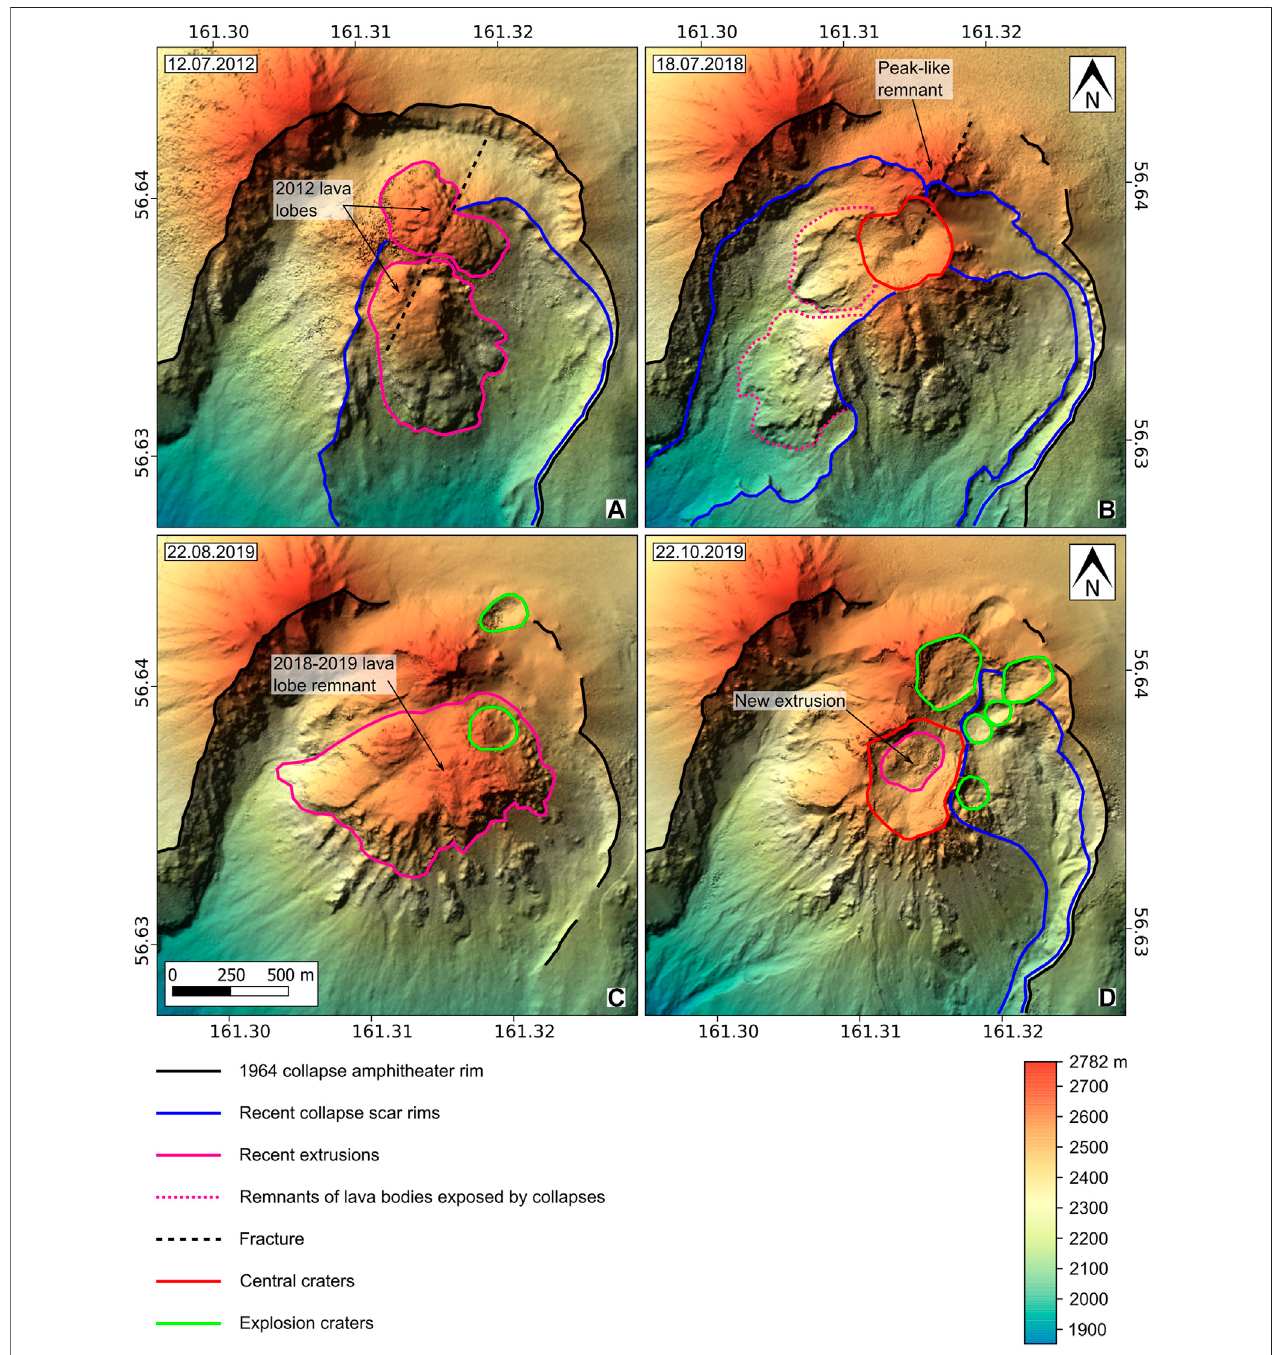
FIGURE3| Hillshade maps oftheYoungShiveluch domefor the2012basemap and three acquisitionscovering the2018 – 2019construction-destructionperiod. Notetheformationofnewcentralcraters(redcircles)andshort-livedexplosioncraters(greencircles).TheDEMswerederivedfromaerialphotogrammetricdata (A,C,D) and from Pleiades satellite data locally complemented by TDX data (B)